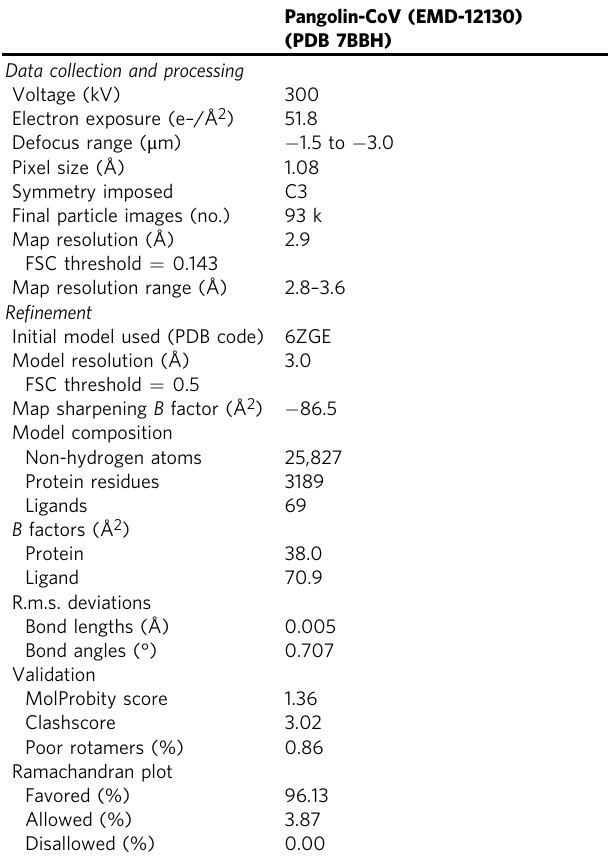
Table 3 Cryo-EM data collection, re fi nement and validation